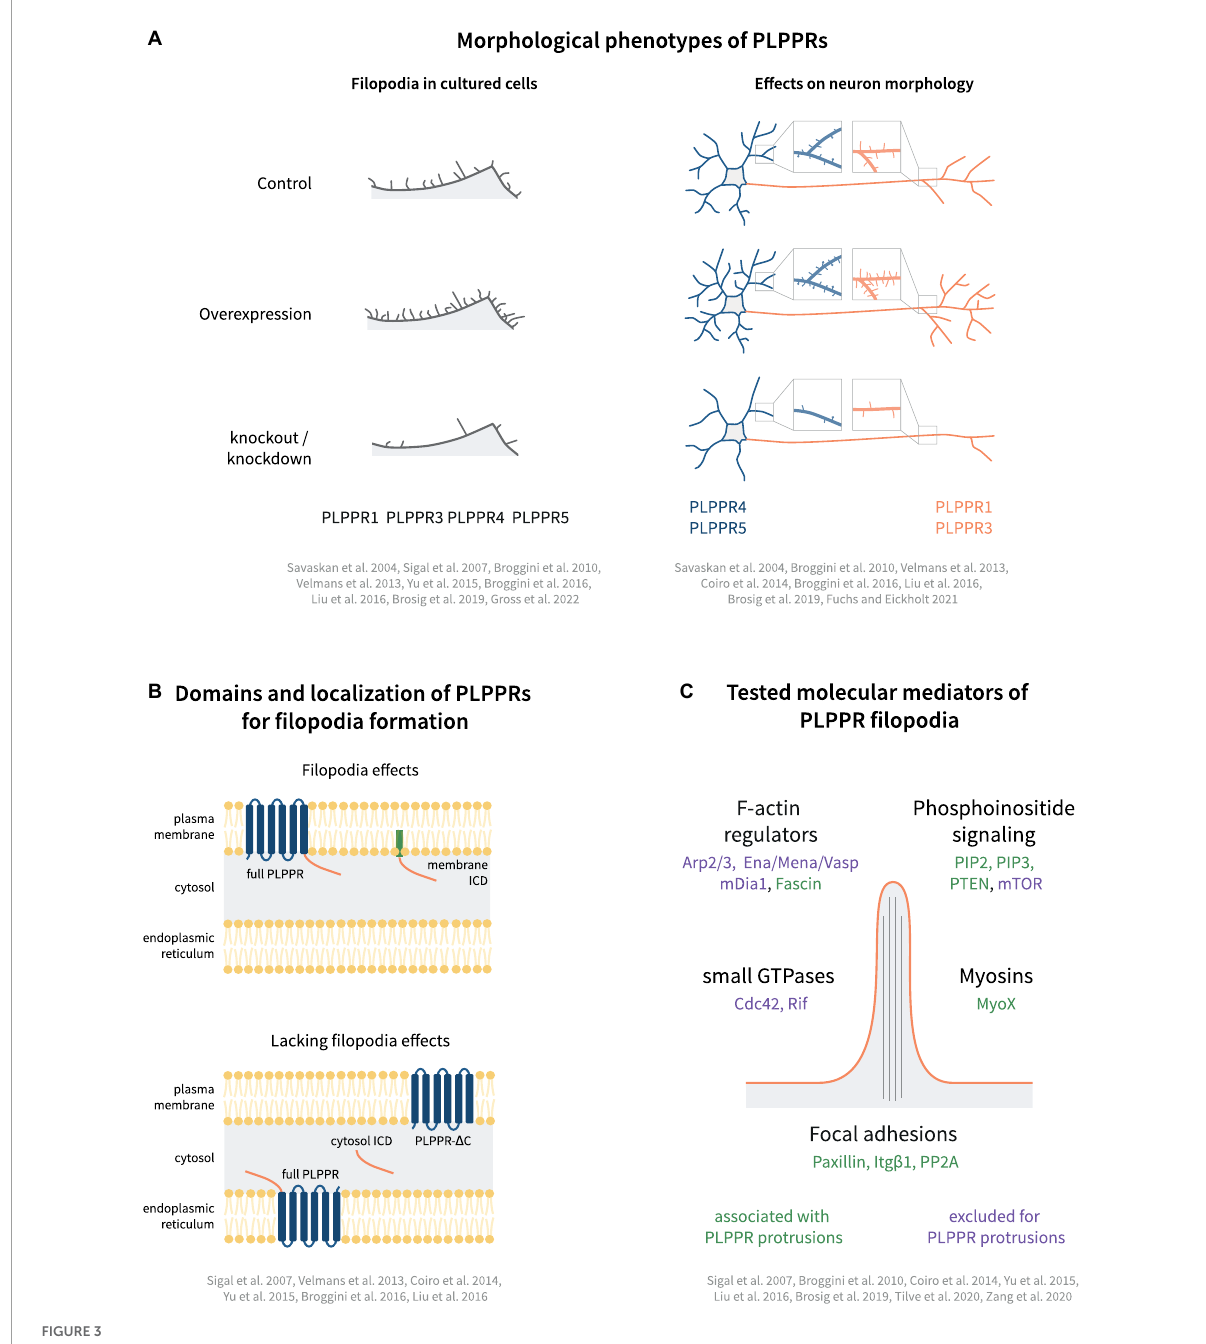
FIGURE3 Models of PLPPR-based membrane protrusions. (A) Effect of PLPPRs overexpression/knockout on filopodia formation in cells, dendrite/dendritic spine morphology (blue) and axon morphology (orange). (B) Plasma membrane localization, is required for induction of filopodia. (C) Cellular regulators involved in PLPPR-induced membrane protrusions, filopodia formation and filopodia stabilization/adhesion. Note that regulators written in green letters are associated with PLPPR-based membrane protrusions, whilst factors written in purple have been tested in a specific experimental paradigm but can be excluded as mediators/regulators. For details, please refer to